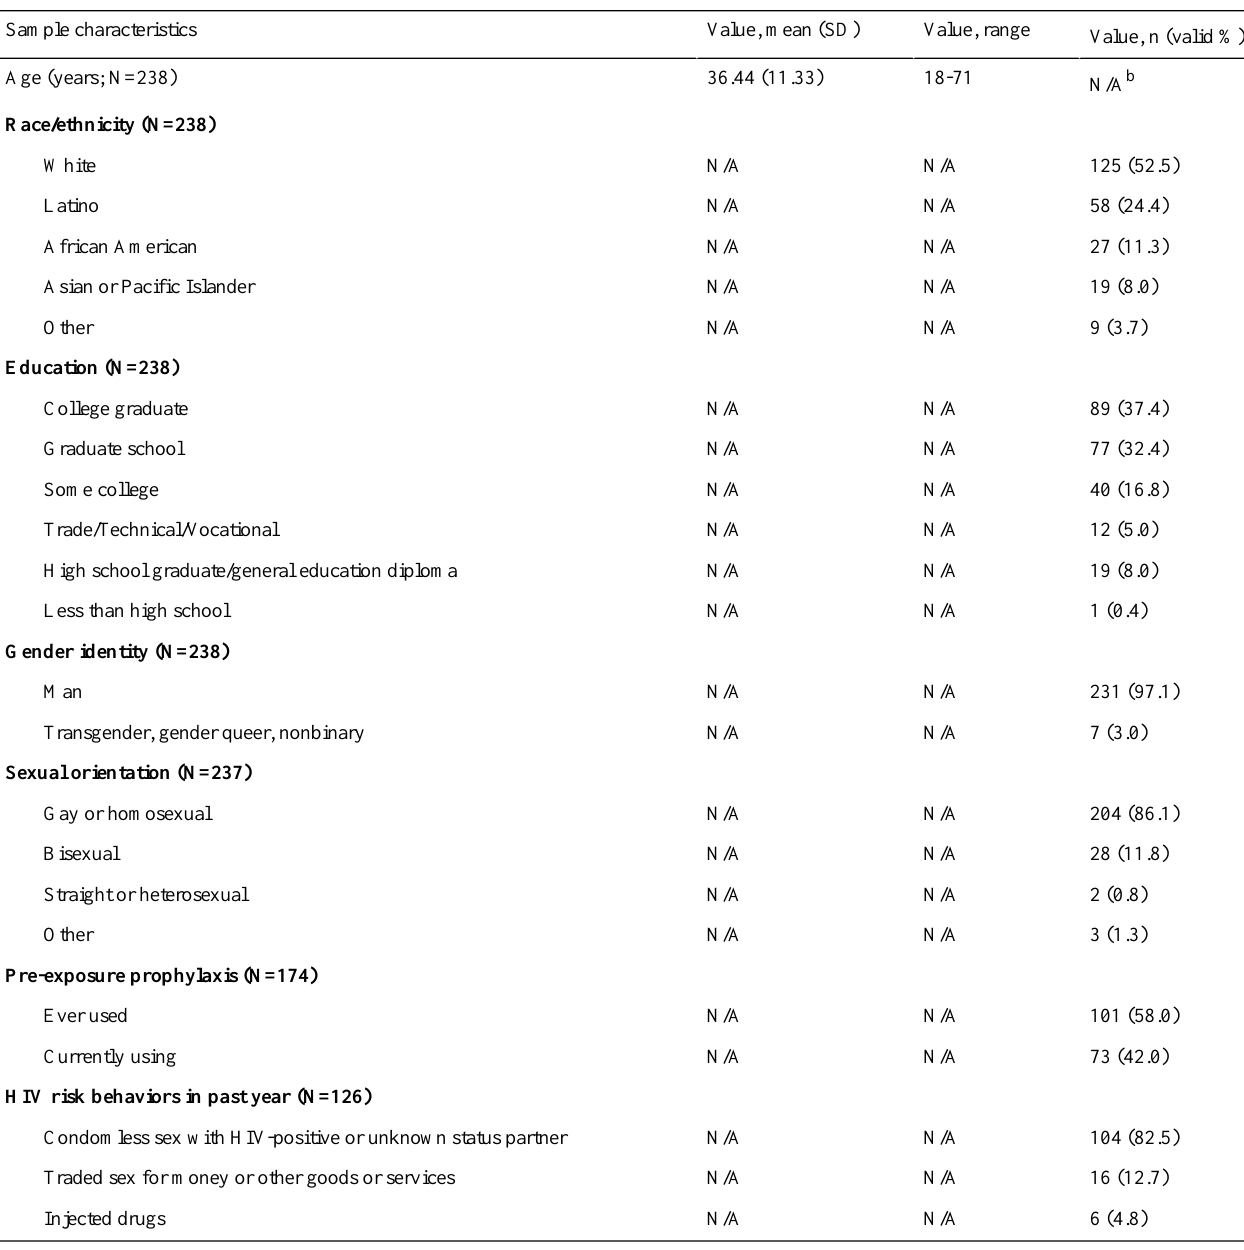
Table 2. Demographic information (stage 4;